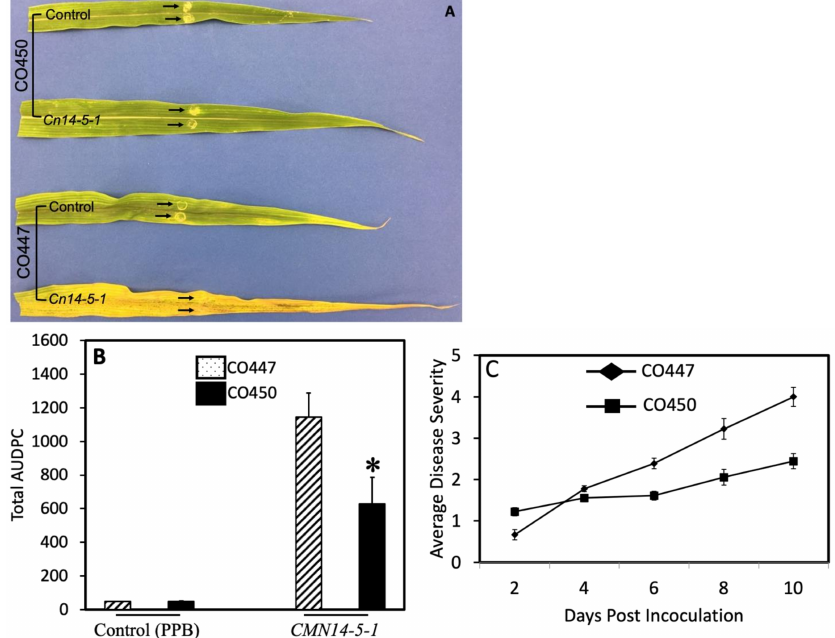
Figure 1. Increased disease resistance to C. nebraskensis (CMN14-5-1) in the tolerant CO450 corn line. ( A ) Phenotype of the tested corn plants at 14 dpi (days post inoculation). Wounded susceptible CO447 and tolerant CO450 plants were pretreated with either the phosphate buffer (PPB; control) or CMN14-5-1 (a highly aggressive Cn strain). Control and inoculated leaves were treated with 20 µ L of buffer or bacterial suspension, respectively. Arrows point to the inoculation site. ( B ) The AUDPC for lesion lengths was calculated in control and inoculated CO447 and CO450 corn lines. Lesion size was measured on CO450 and CO447 leaves from day 2 to day 10 after inoculation with CMN14-5-1. Asterisks denote significant differences, * p < 0.05. ( C ) Progression of disease severity in CO447 and CO450 lines from 2 to 10 dpi was calculated using a disease severity scale of 0–5. The values represent the AUDPC values mean of 6 biological replicates and standard error was represented over